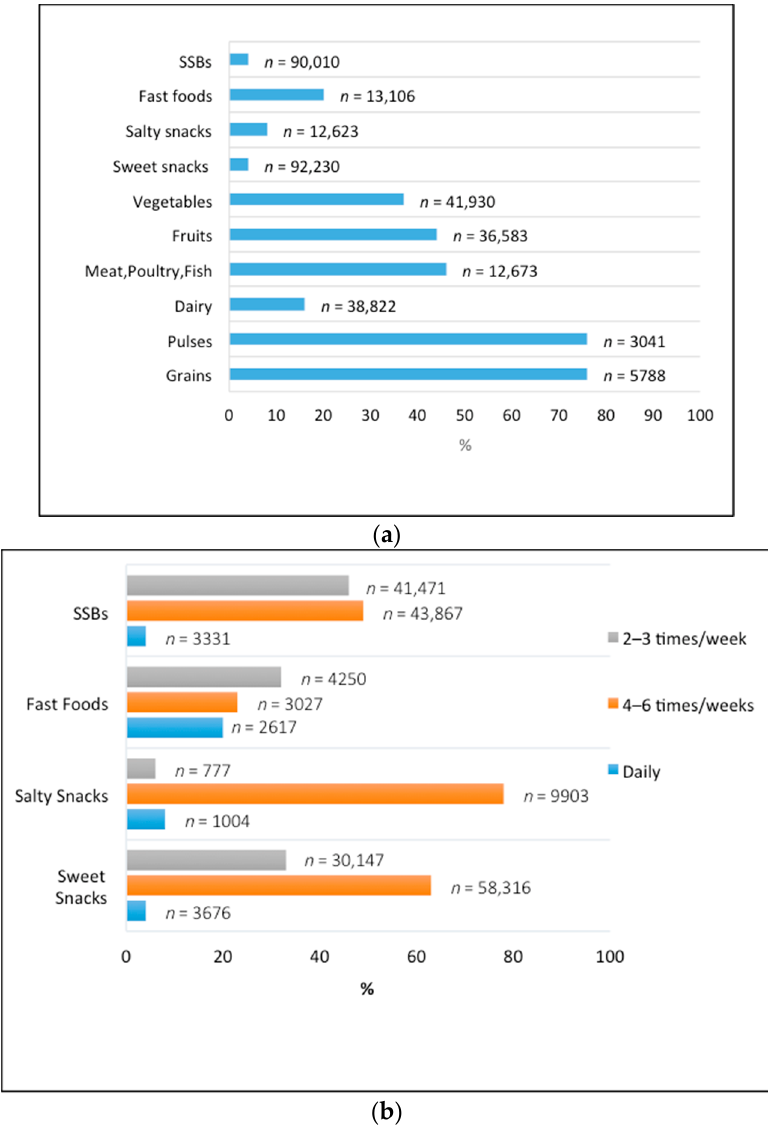
Figure 5. ( a ) Daily intake of food groups reported by adolescent girls; ( b ) Frequency of consumption of energy-dense foods (sweet and salty snacks, fast foods, and SSBs) by adolescent girls.